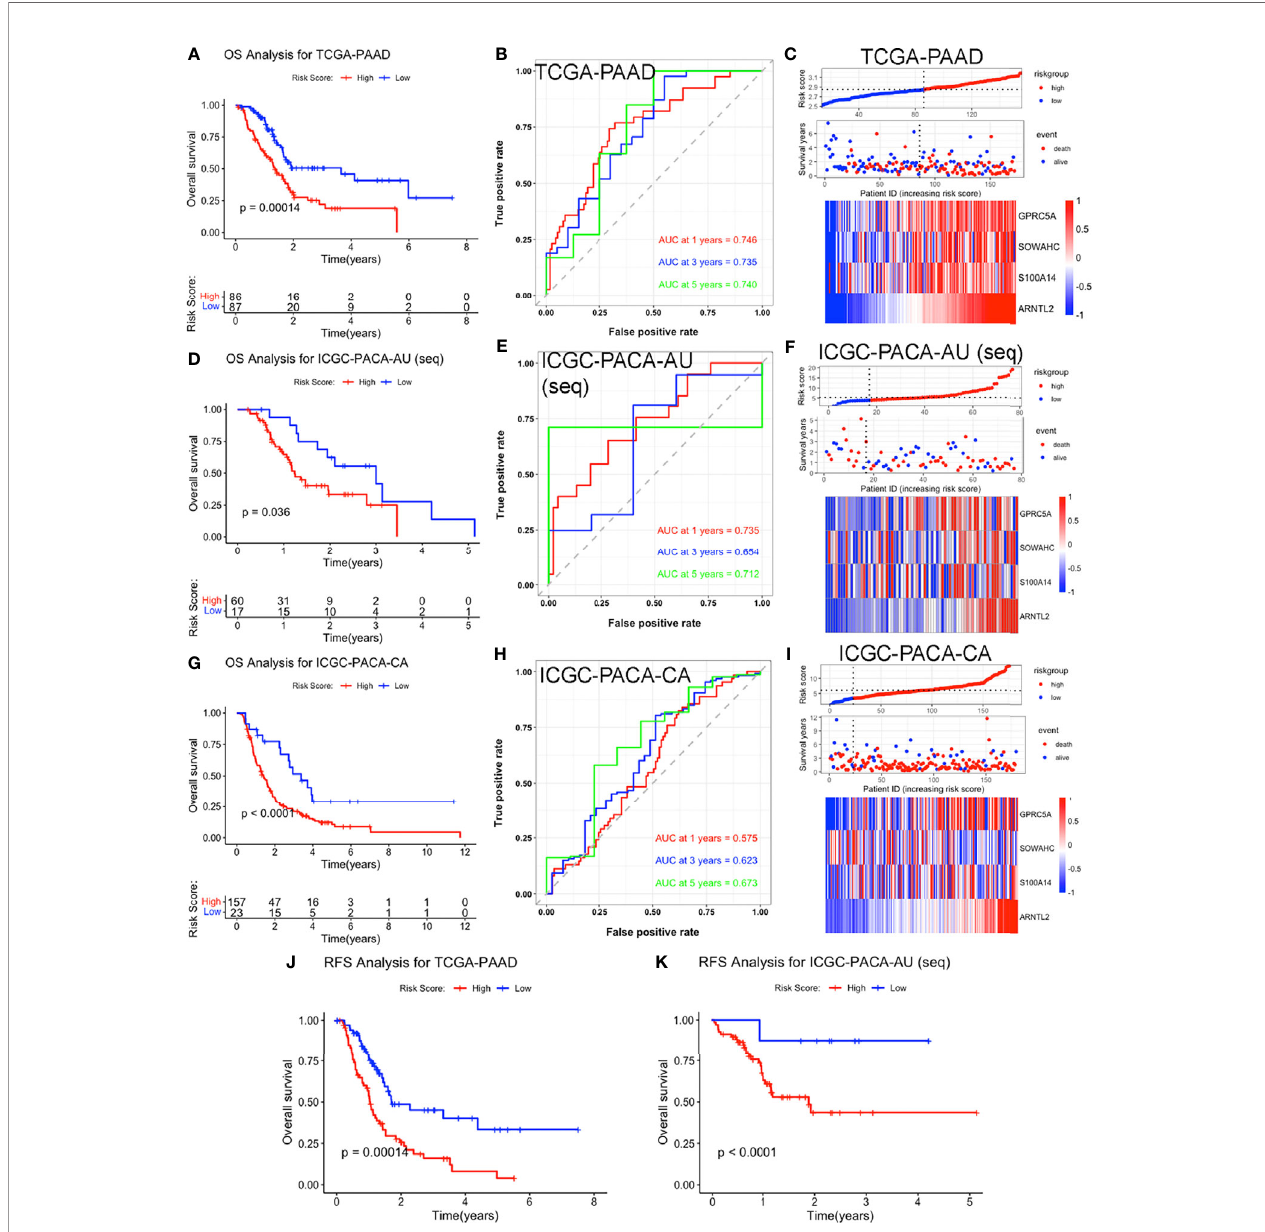
FIGURE 3 | Validation of the four-MDG signature in the TCGA-PAAD, ICGC-PACA-AU (seq), and ICGC-PACA-CA datasets. (A, D, G) K-M survival curves showing OS of patients in the high and low risk-score subgroups across three datasets. (B, E, H) Time ‐ dependent ROC curves of the signature. (C, F, I) Risk-score distribution plots for the three datasets. In each plot, from top to bottom: distribution of risk-scores, distribution of survival status, expression patterns of the four genes. (J, K) K-M analysis for RFS of high and low risk-score subgroups in TCGA-PAAD and ICGC-PACA-AU (seq)